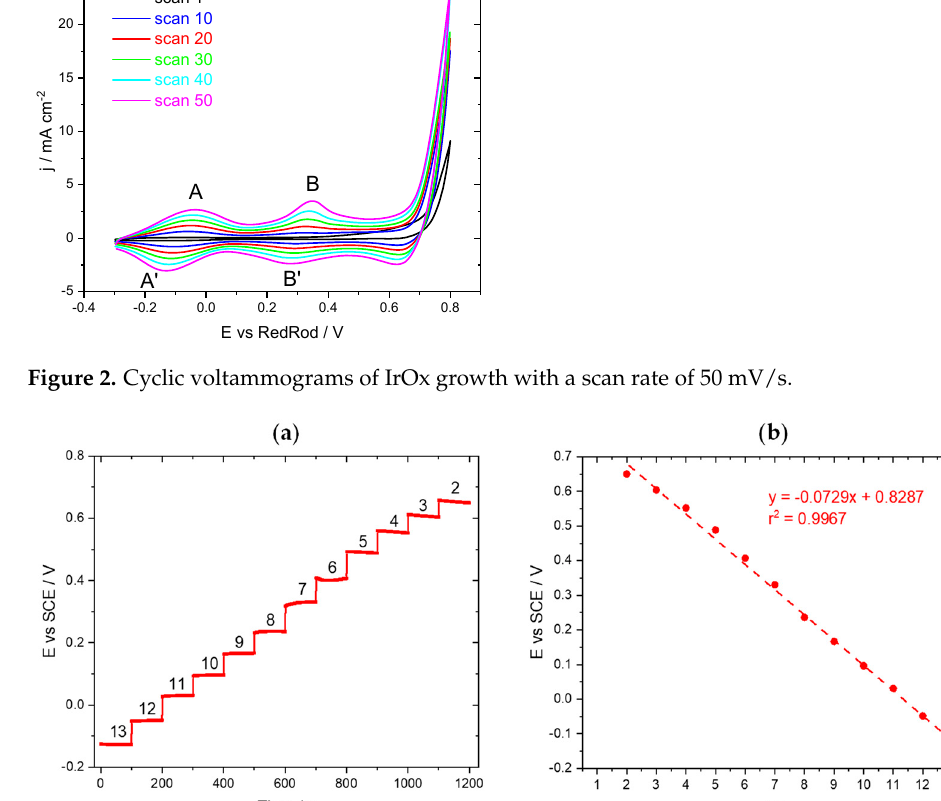
Figure 3. ( a ) Potentiometric response to pH and ( b ) corresponding calibration curve of an IrOx sensor.